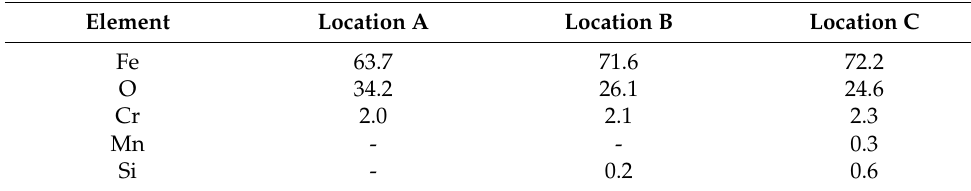
Table 7. Quantitative EDX analysis, sample P91 oxidized for 3000 h at 600 °C (in wt.%).